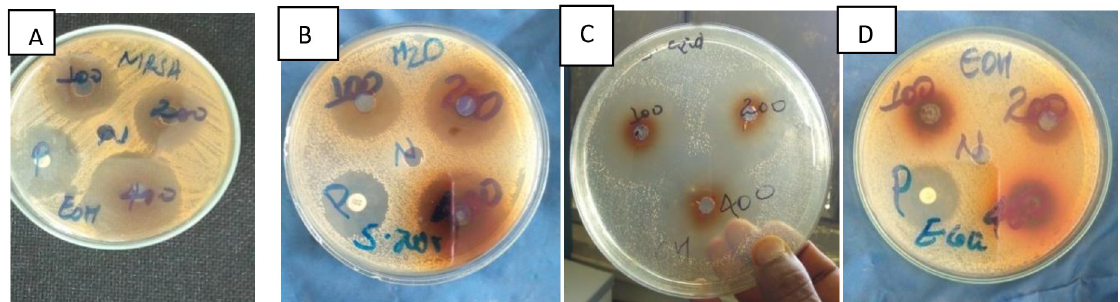
Fig 1. Example of antimicrobial activity of plant extracts using agar diffusion: MRSA by ethanol extract (A), S. aureus by aqueous extract (B), S. epidermidis by ethanol extract ( C), E. coli by ethanol extract (D) at 100,200,400mg/ml concentrations.